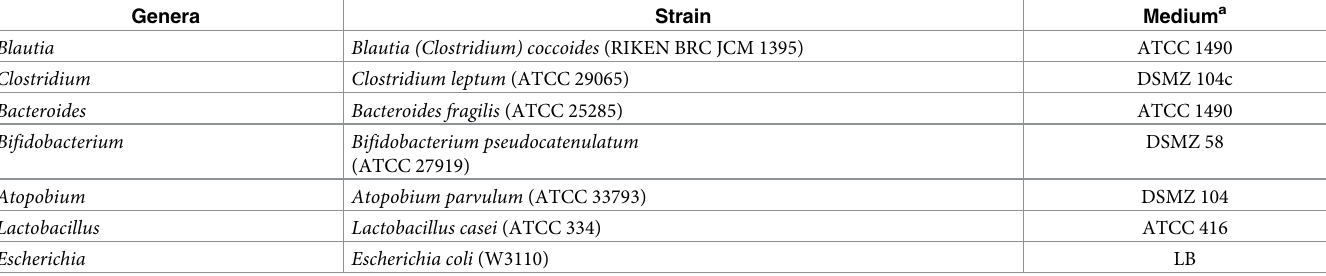
Table 1. Bacterial strains used for quantification of hydrogen production and the culture medium.